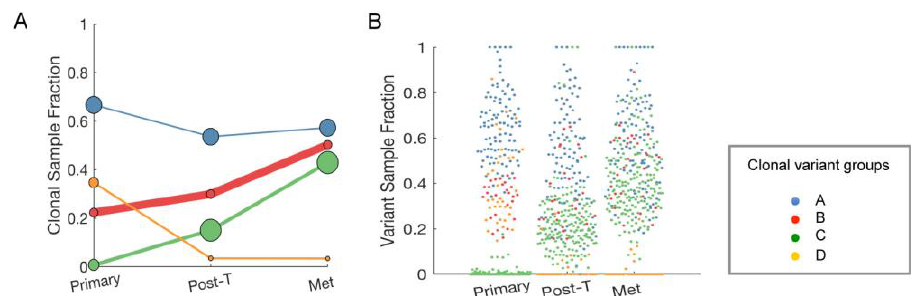
Figure 7. Evolution of single nucleotide variants (SNVs) in longitudinal samples. ( A ), The proportion of cells expected to have the SNVs in each clonal variant group in each sample. LumosVar2 was used to assign mutations to clonal variant groups. Clonal variant group A (blue) was present in all of the tumor cells; clonal variant groups B (red) and C (green) increased in abundance overtime; clonal variant group D (orange) was present in the primary tumor but is mostly not detectable at the later time-points. The size of the circles is proportional the number of mutations detected in the sample in that clonal variant group, and the thickness of the line represents the proportion of copy number alterations assigned to the clonal variant group. ( B ), The proportion of cells in the sample estimated to have the mutation is plotted for each sample. Each point represents a mutation, and the color indicating the clonal variant group. Post-T, post-trastuzumab; Met, metastasis.